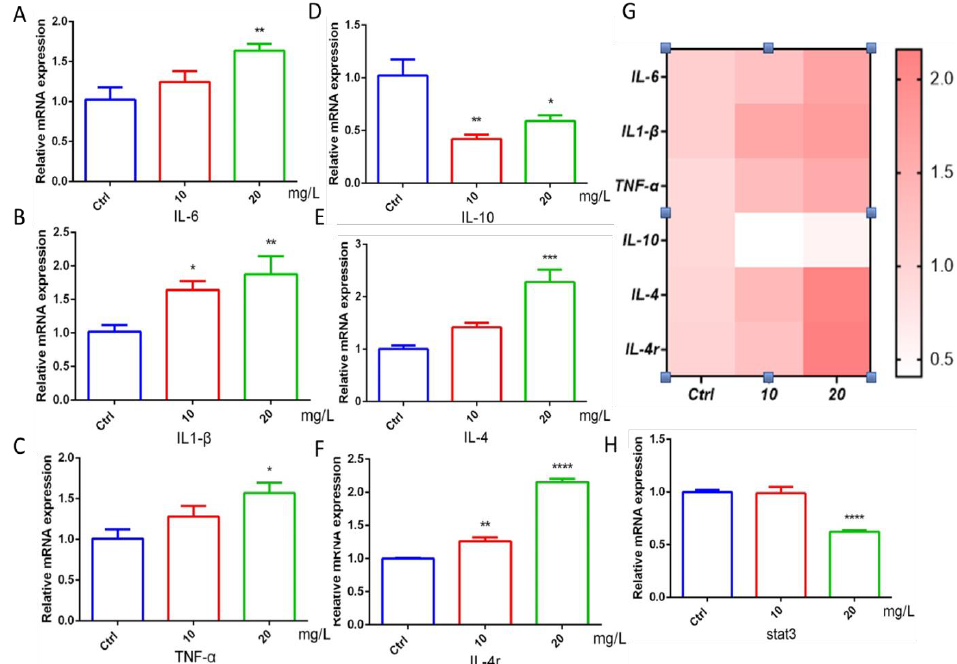
Figure 4. 6-BA induced inflammation in zebrafish at 72 hpf. ( A – C ) Expression of IL-6, IL1- β, and TNF- α, the hallmark proinflammatory factors of inflammatory response in zebrafish treated with 6-BA. ( D – F ) The mRNA levels of the landmark anti-inflammatory factors IL-10, IL-4, and receptor IL-4r in zebrafish. ( G ) Heatmap of inflammatory-response-related genes. Red indicates higher values than the control, and darker colors indicate larger values compared with the control. ( H ) Relative mRNA expression of stat3 , a downstream target gene of IL-4. Values are expressed as mean ± standard error (SEM). N = 3. * p < 0.05, ** p < 0.01, *** p < 0.001, **** p < 0.0001.